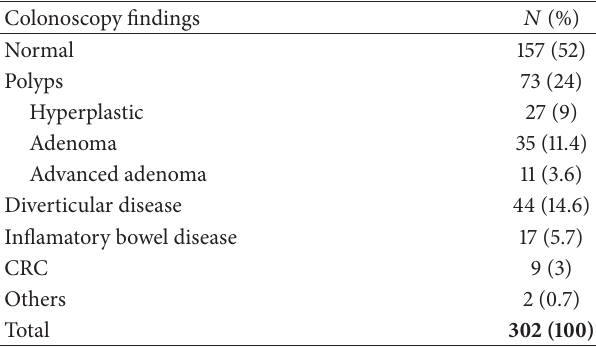
Table 3: Colonoscopy findings in the study population.